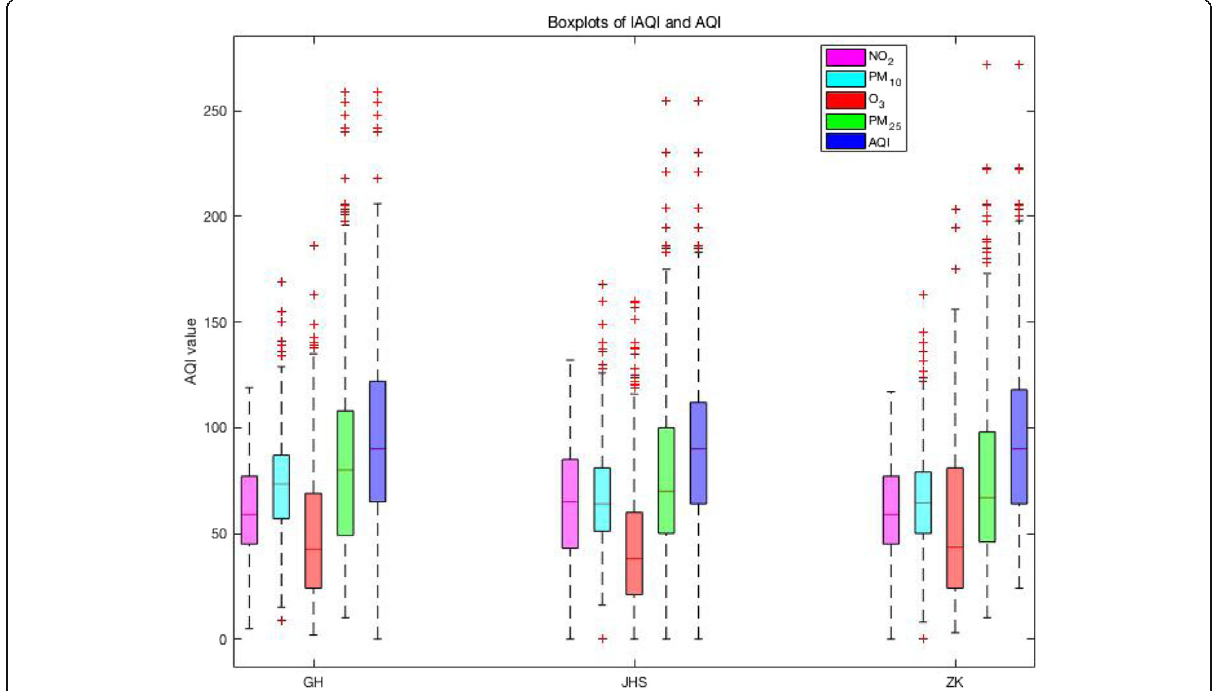
Fig. 1 Boxplots of IAQI and AQI. The boxplots depict the general span of IAQI (NO 2 , PM 10 , O 3 , PM 25 ) and the AQIs in above three localities. The first group of boxplots is the distribution of these five pollutants in the GH locality. The second group of boxplots is the distribution of these five pollutants in the JHS locality. The third group of boxplots is the distribution of these five pollutants in the ZKX locality. The color of boxplot indicates the type of air